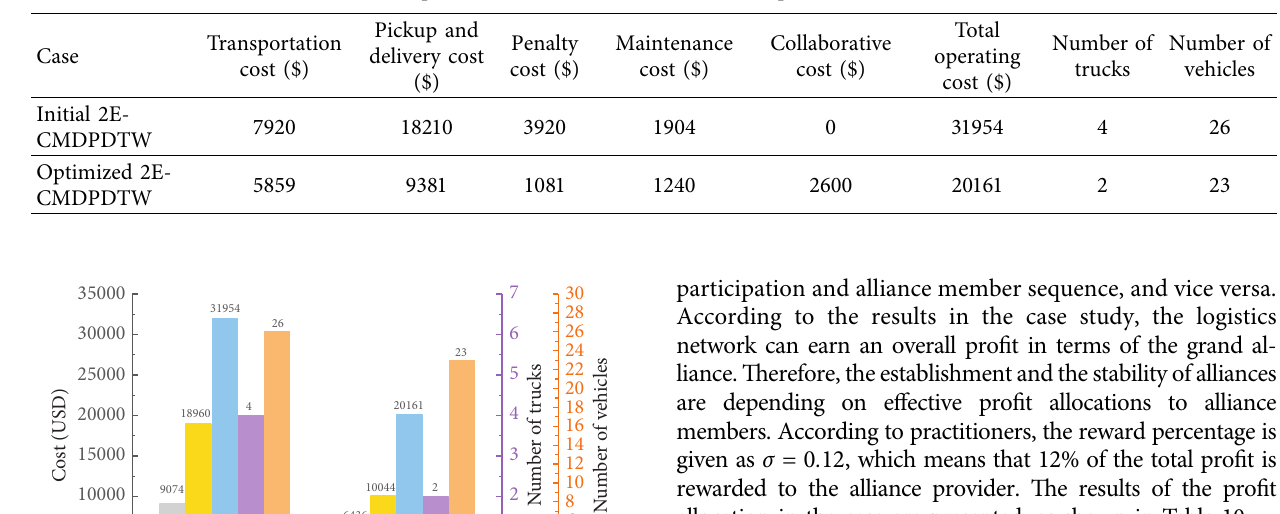
Figure 8: Comparison of the costs, number of trucks, and number of vehicles of alliances. Table 9: Comparative results of the initial and the optimized 2E-CMDPDTW.